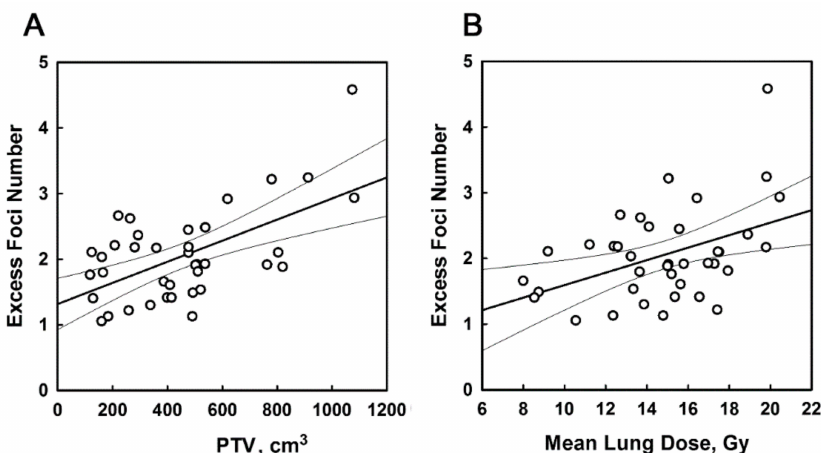
Figure 5. Correlation of the excess foci number with planned treatment volume (PTV) and mean lung dose (MLD). ( A ) PTV and ( B ) MLD correlation analysis for a group of patients with blood samples collected at 1 h after first RT session. Each point represents the data for an individual patient. The excess foci number is calculated as the product of the average radiation-induced fpc and the fraction of irradiated cells from Table S3. The lines show the linear regression and 95% confidence intervals. Correlation coe ffi cient r = 0.586, p = 0.00011 for PTV and r = 0.437, p = 0.0006 for